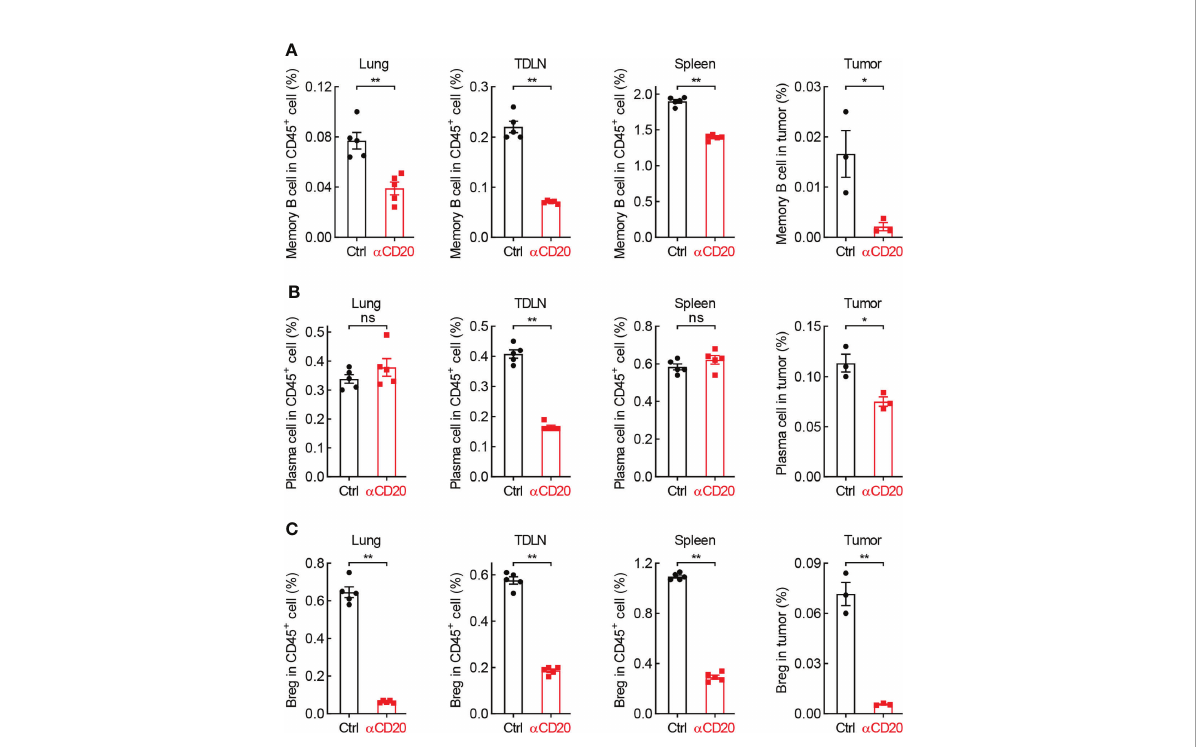
FIGURE 7 B cell subsets are diminished by CD20 blockade in lung cancer. (A) FACS data showing fewer memory B cells in multiple tissues and organs from mice with a CD20-mediated B cell depletion. (B) FACS data showing reduced plasma cells in TDLN and tumor, but not lung tissue and spleen from mice with a CD20-mediated B cell depletion. (C) FACS data showing decreased Breg cells in multiple tissues and organs from mice with a CD20-mediated B cell depletion. TDLN: mediastinum lymph node. Lung tissue: n = 5; TDLN: n = 5; Spleen: n = 5; Lung tumor: n = 3. Student ’ s t test (two tailed, unpaired) was performed. Data represented means ± SEM. * p < 0.05; ** p < 0.01; ns, not statistically signi fi